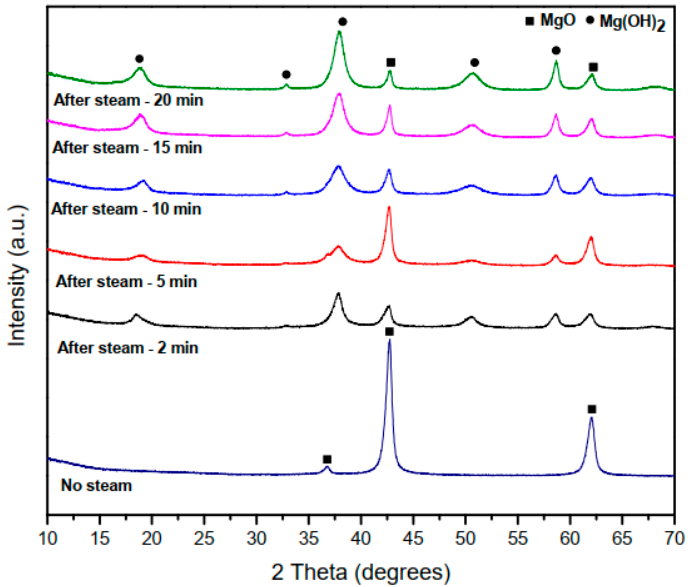
Figure 2. A comparison of XRD patterns for samples before exposure to steam (no-steam) and after exposure to steam for 2-min, 5-min, 10-min, 15-min, and 20-min, at 100 °C. The sample morphology was analyzed using SEM images, which are shown in Figure 3 below.